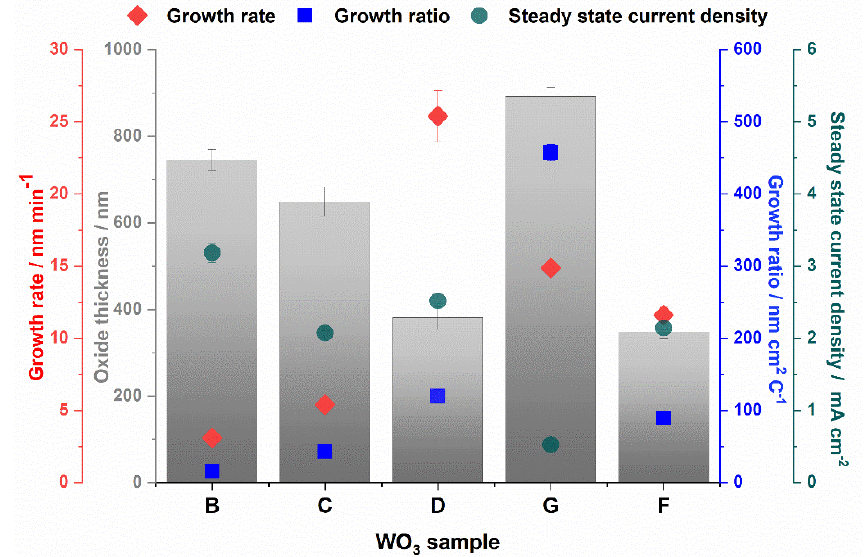
Figure 4. The oxide growth rate (red), growth ratio (blue), steady state current density (green), and oxide thickness of WO 3 layers obtained in different anodizing conditions.